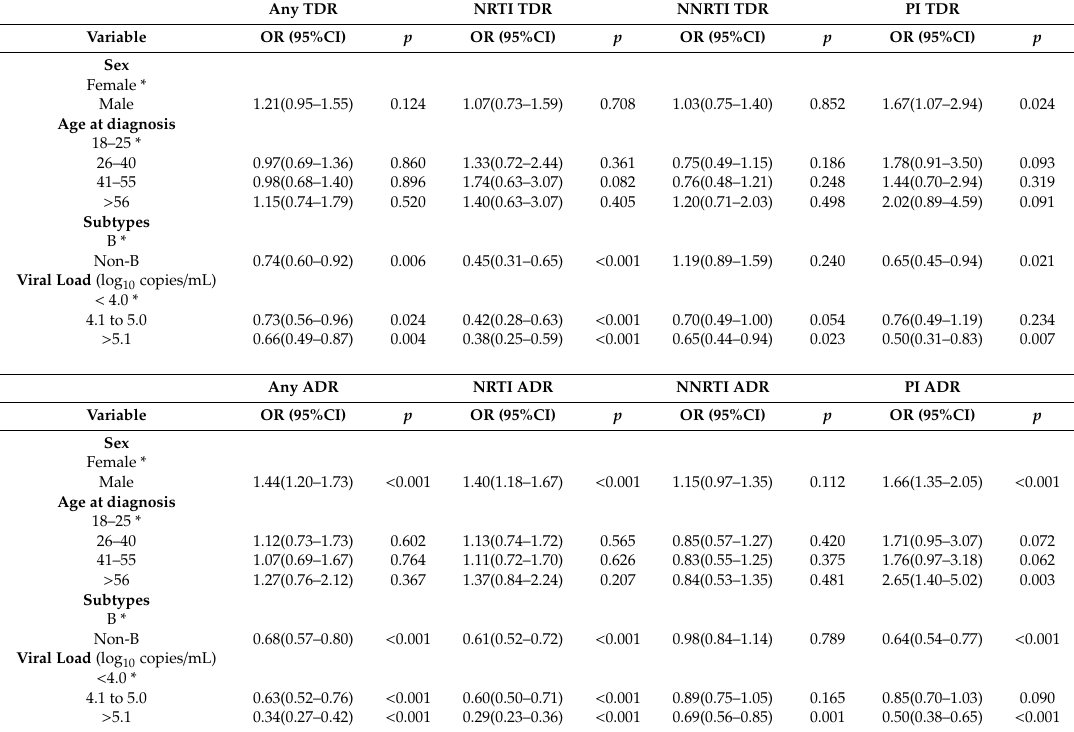
Table 3. Multiple regression analysis of factors associated with HIV-transmitted drug resistance. TDR, transmitted drug resistance; ADR, acquired drug resistance; CI, confidence interval; OR, odds ratio. * p <